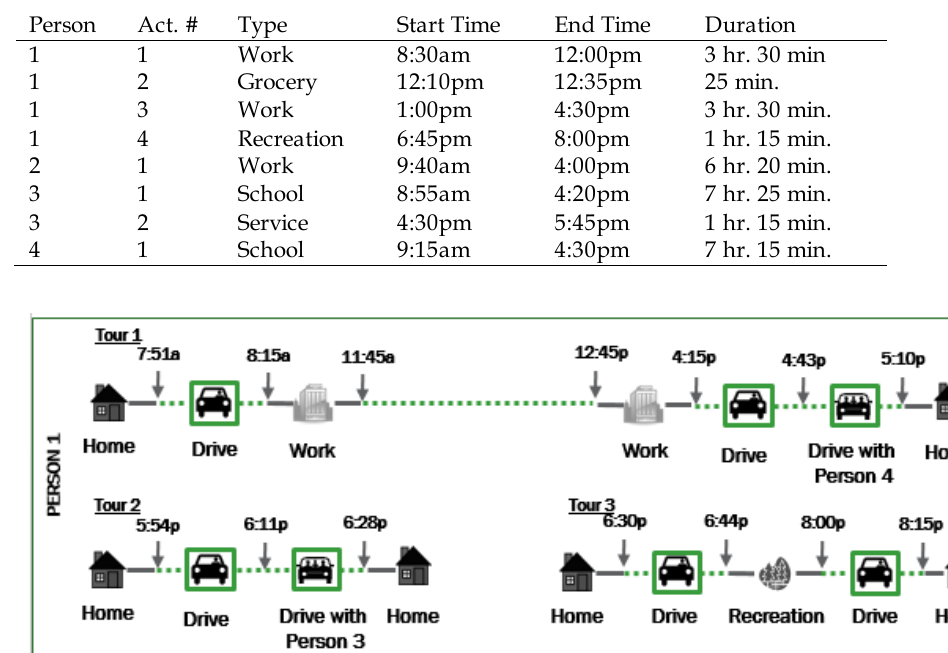
Table 7. Activity List for Example Household with Dependents